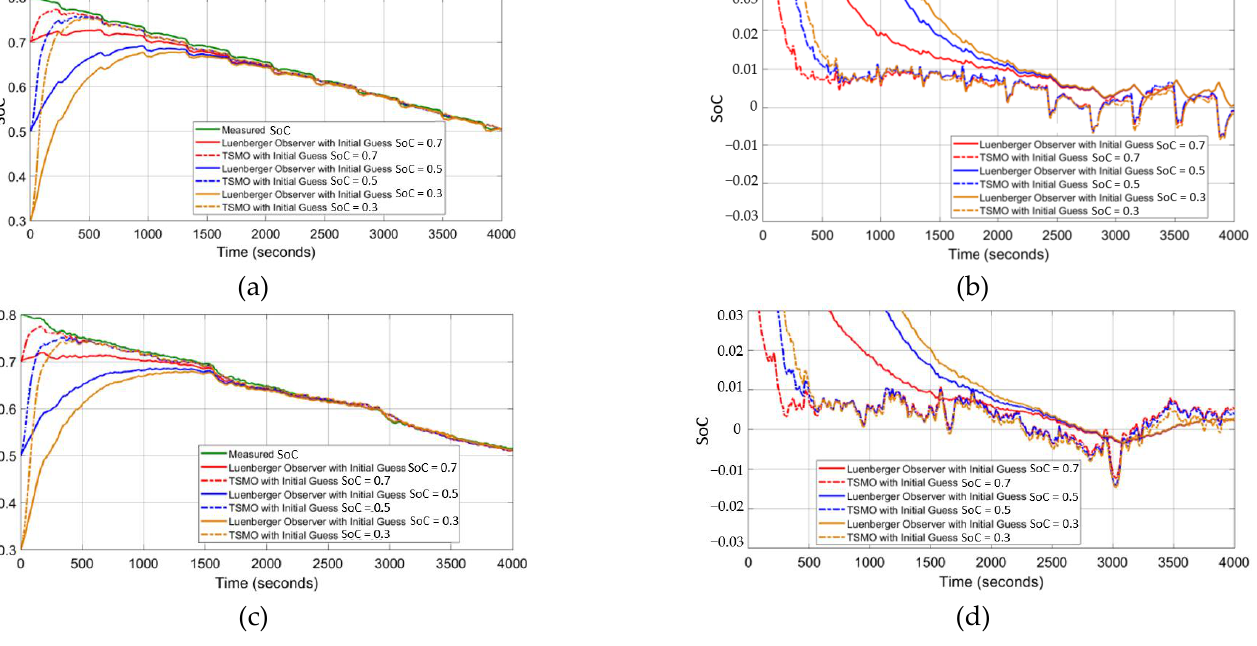
Figure 5. Comparison results between Luenberger observer and TSMO with different initial SoC guess values: ( a ) SoC estimation results under DST; ( b ) SoC estimation error under DST; ( c ) SoC estimation results under FUDS; and ( d ) SoC estimation error under DST.